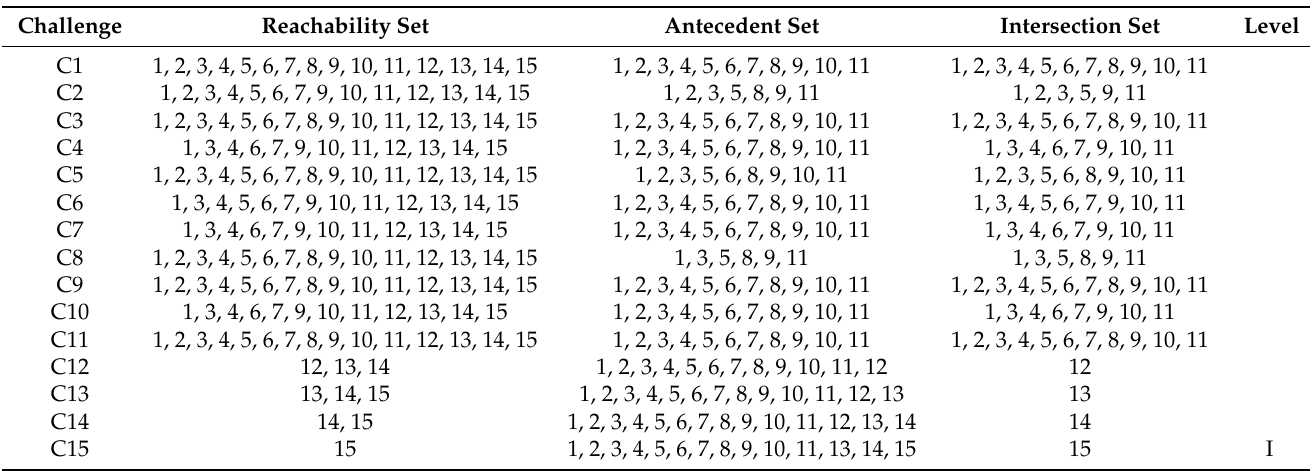
Table 7. Iteration 1 of level partitions.